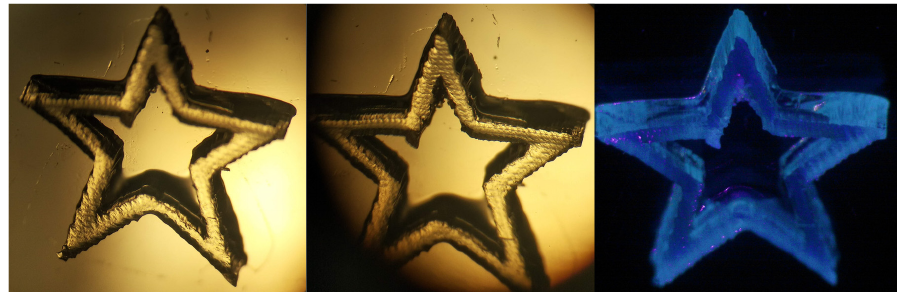
Figure 12. The pattern obtained after the 3D printing experiment based on formulation with T1 (0.07% wt.)/IOD (0.33% wt.) and TMPTA.